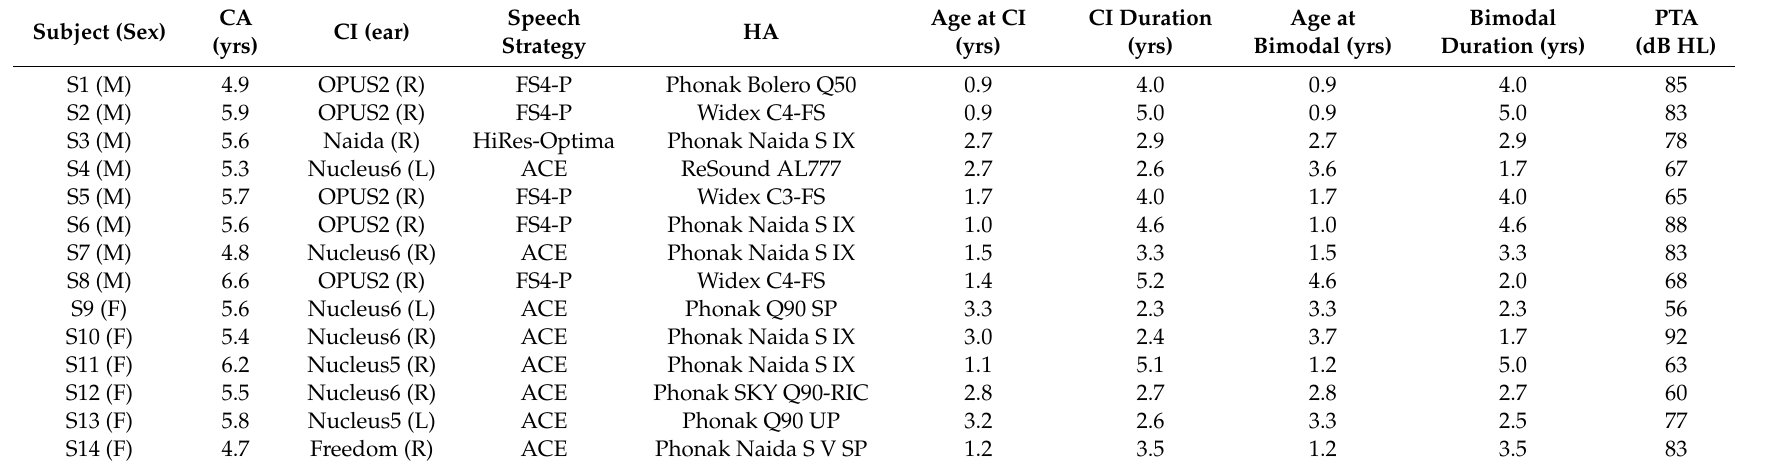
Table 1. Demographic information of the